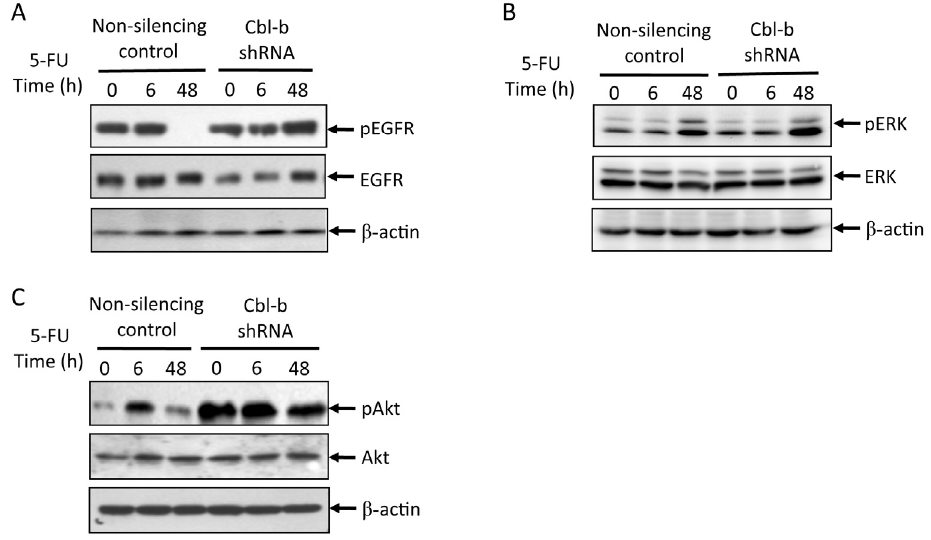
Figure 5. Effects of 5-FU on pEGFR, EGFR, pERK, ERK, and pAkt and Akt expression in MGC803 cells transfected with non-silencing control and Cbl-b shRNA. ( A – C )